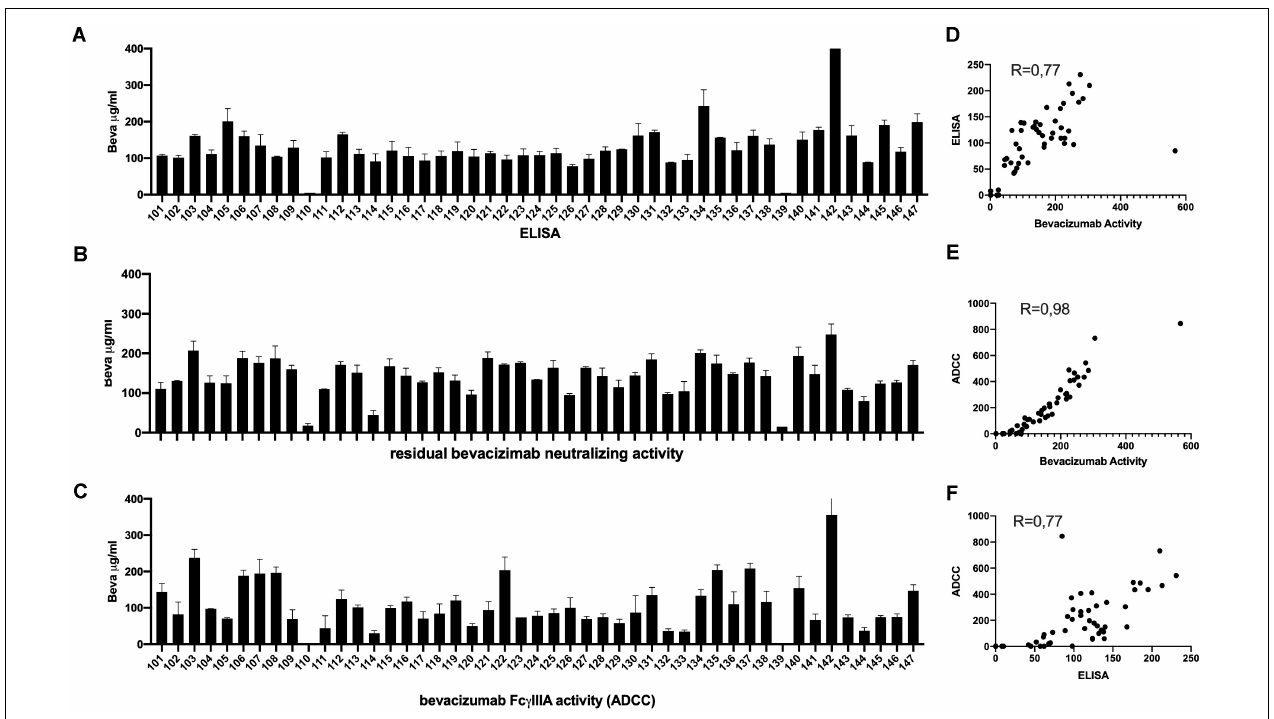
FIGURE 4 | Serum samples from 46 patients with ovarian cancer described in Supplementary Table S1 were tested after four cycles of bevacizumab treatment for the presence of circulating levels of bevacizumab determined by ELISA (Panel A), and for the ability of bevacizumab to neutralize VEGF (Panel B), and to activate ADCC activity (Panel C) as described in the section “Materials and Methods.” To eliminate possible non-specific effects, the ADCC activity of each serum sample was first determined using both mVEGF (+) and mVEGF( − ) target cells and the values obtained in the presence of the mVEGF( − ) target cells were subtracted from those obtained using the mVEGF (+) and the final results were determined by interpolation of the standard curve of bevacizumab activity ( Figure 3 , Panel A) using the Prism software (GraphPad, France). The values obtained for the circulating levels of bevacizumab determined by ELISA were compared with the values obtained for the neutralization of VEGF activity (Panel D) or the values obtained for the ADCC activity of bevacizumab were compared with the values obtained for the neutralization of VEGF activity (Panel E) or the circulating levels of bevacizumab determined by ELISA (Panel